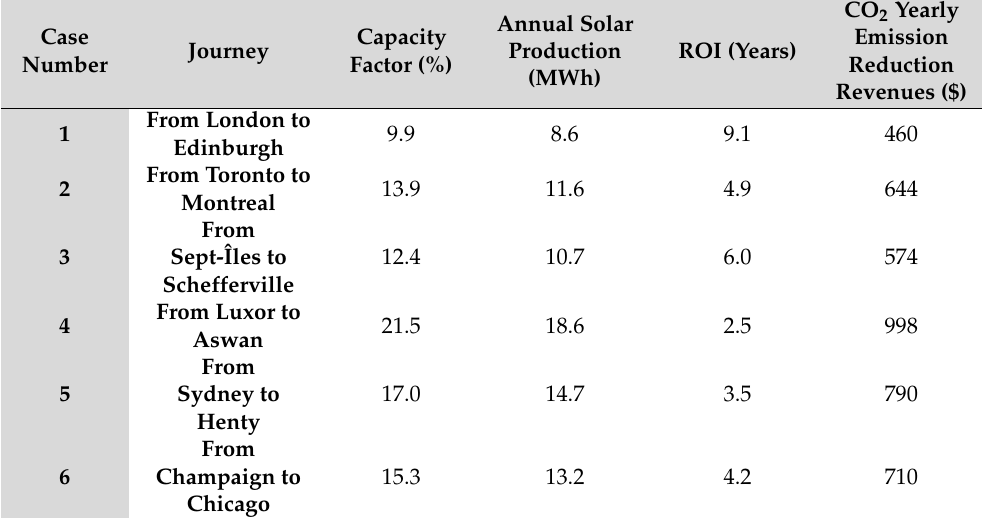
Table 5. The main results from RETScreen for installing PV solar panels on the wagon’s roof (per